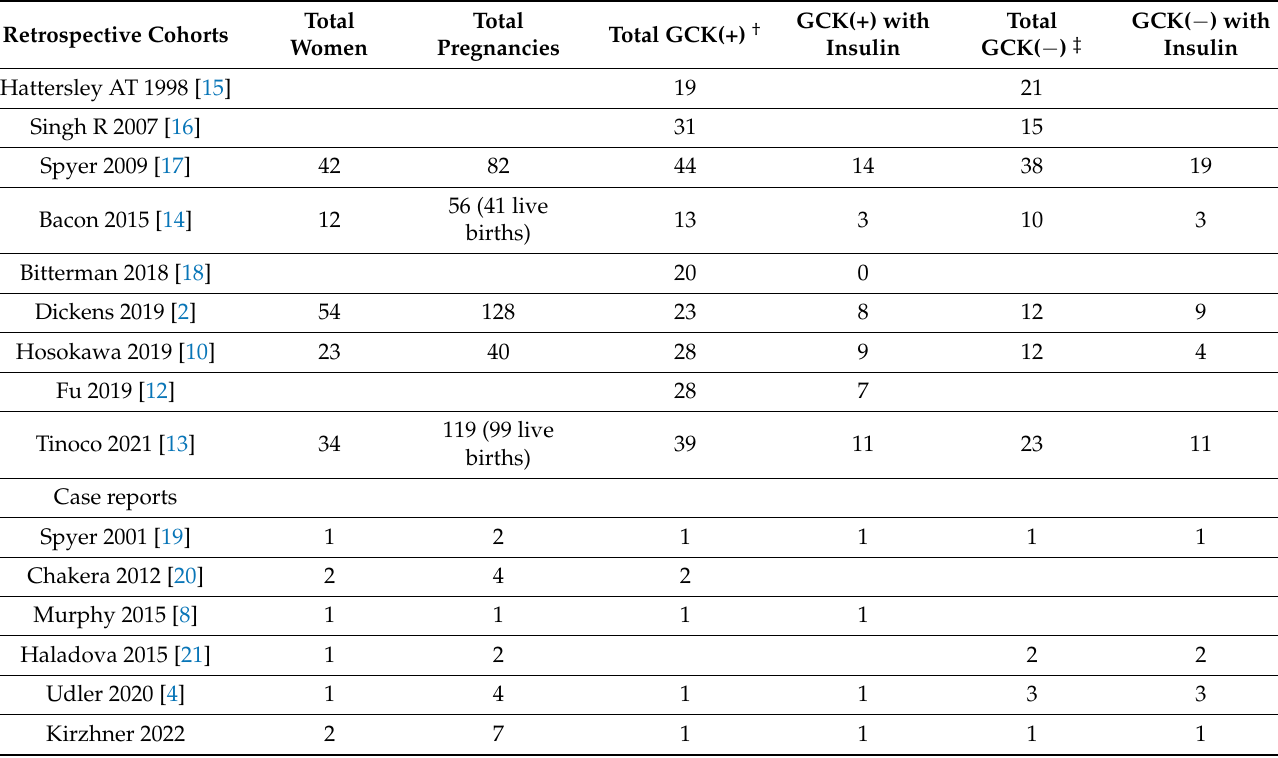
Table 1. Publications of Pregnant GCK − MODY Women with Known Fetal Mutational Status: Review of Maternal and Fetal